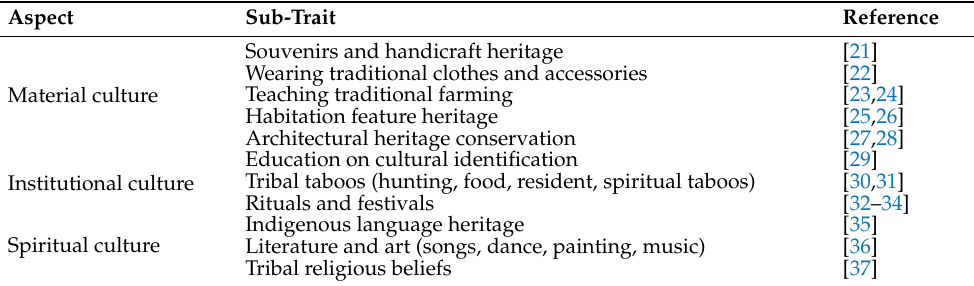
Table 1. The evaluation criteria for cultural vicissitudes. Aspect Sub-Trait Reference Souvenirs and handicraft Material culture